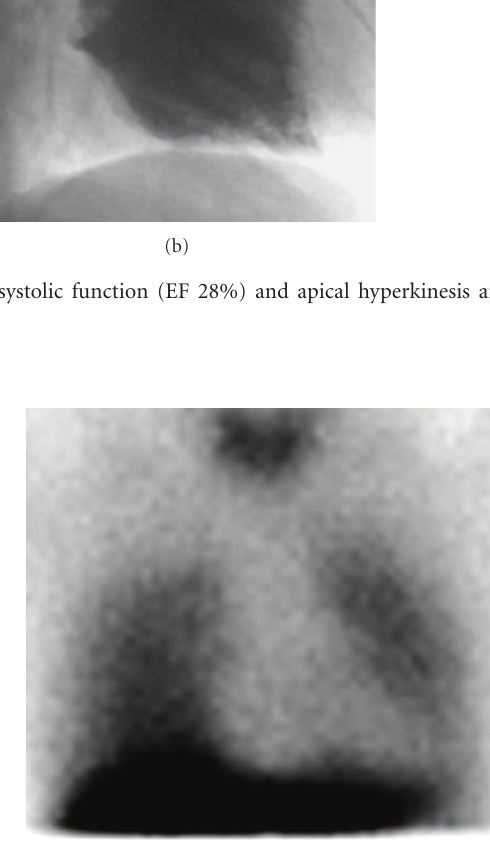
Figure 2: SPECT images showing a decreased myocardial 123 I- MIBG uptake in the whole left